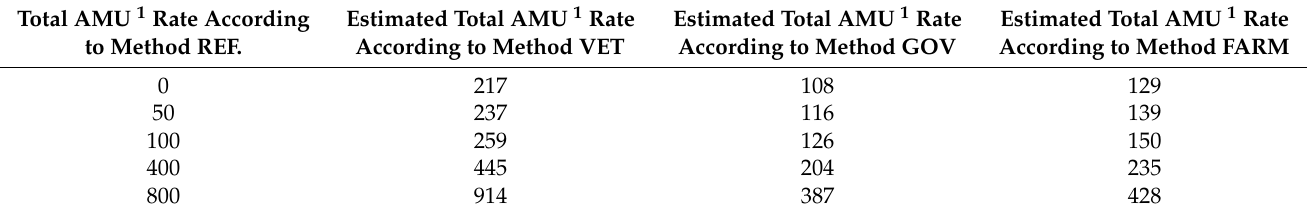
Table 3. Estimates of the total usage rate of antimicrobial agents (from products other than medicated feed) in dairy farms from Qu é bec, Canada, according to veterinary invoices (VET method), the governmental database (GOV method), or farm treatment records (FARM method) when a given total usage rate of 0, 50, 100, 400, or 800 DCDbovCA/100 cow-years is reported using a garbage can audit (REF method). Estimates were calculated using negative binomial regression models applied to 101 (VET and GOV methods) or 97 (FARM method) dairy farms with the total usage rate of antimicrobial agents according to the REF method as the only predictor in each model.